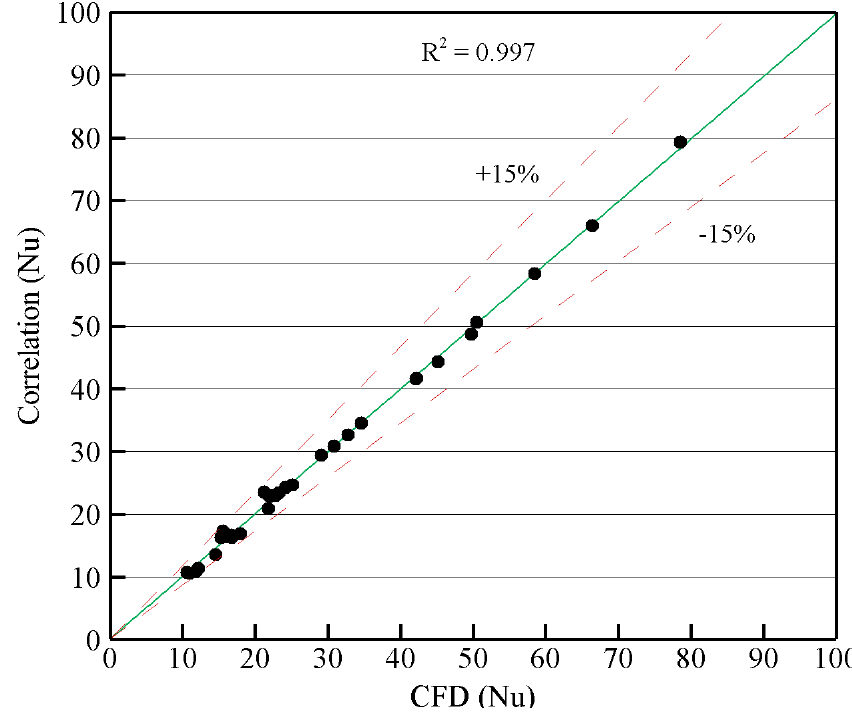
Figure 16. Correlated data of the study.